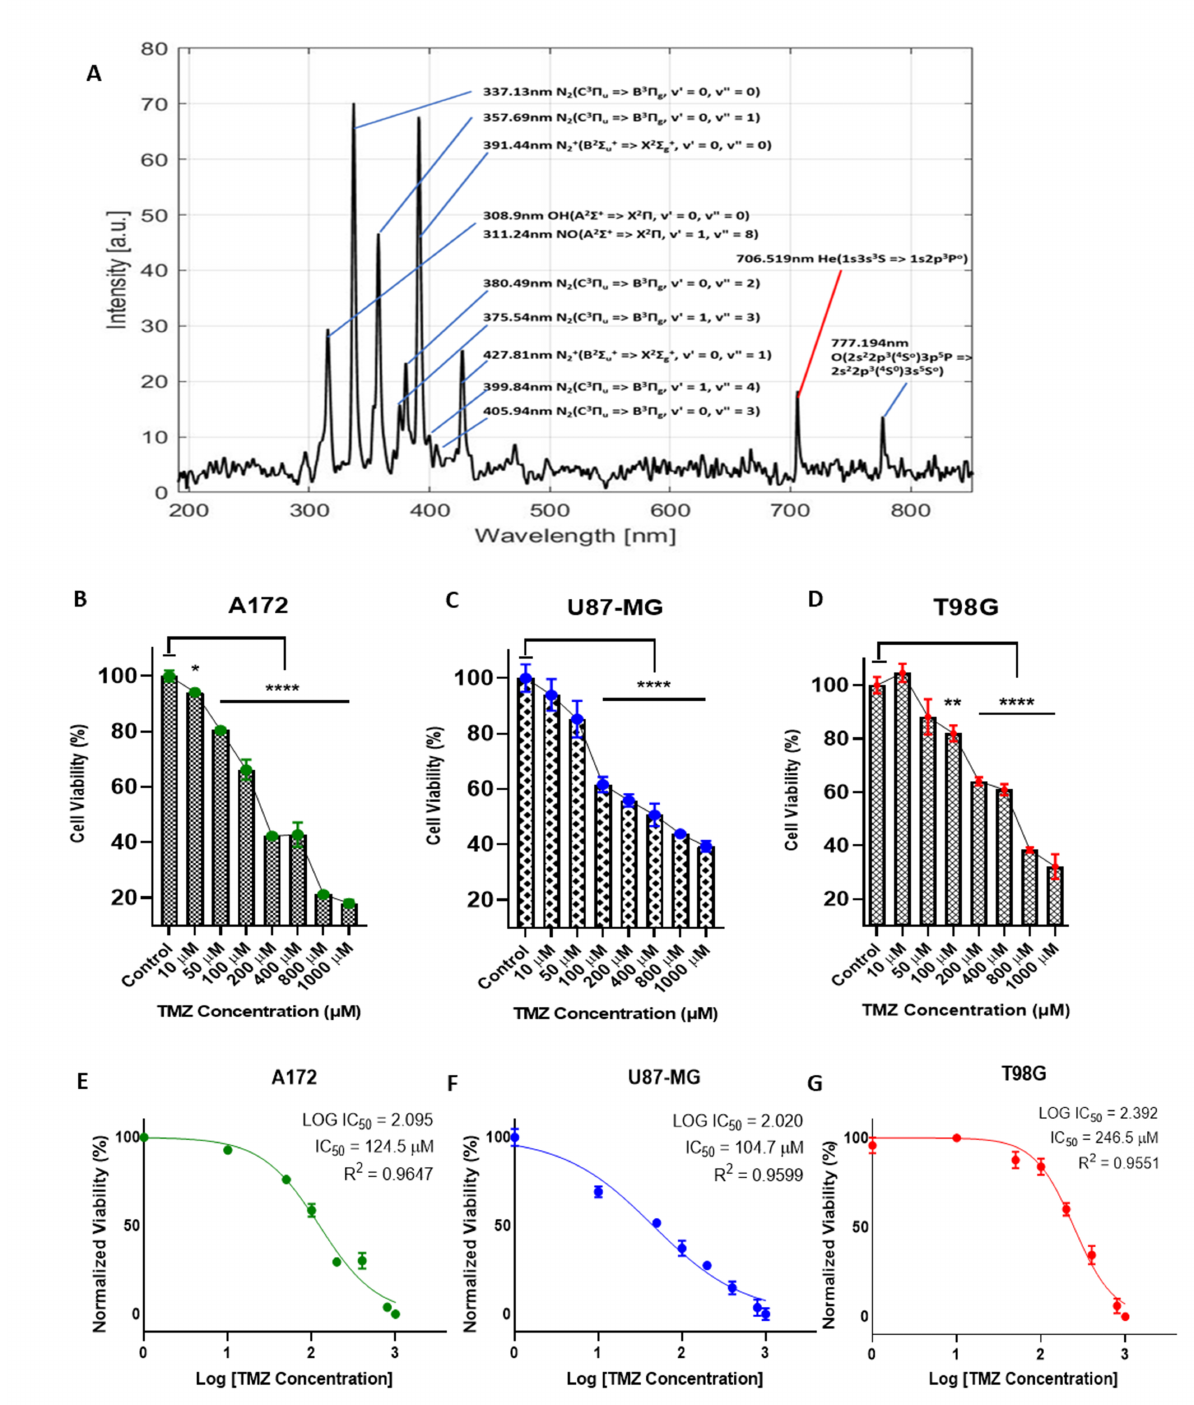
Figure 1. ( A ) Optical Emission Spectroscopy of the CAP jet using SpectraWiz ® showing most peaks of nitrogen C3 Π u => B3 Π g ranging from the spectral region of about 300–490 nm. Relative cell viability (%) for the GBM tumor cell line A172 ( B ), U87-MG ( C ), and T98G ( D ) 72 h following a single TMZ treatment. The log IC50 after 5-day TMZ treatment of A172 ( E ), U87-MG ( F ), and T98G ( G ) cell lines. Cell viability measures were collected 96 h after TMZ treatment. All data represent the mean ± SE, and all experiments were performed in quadruplets. Data were analyzed using Student’s t -test * p < 0.05; ** p < 0.01; and **** p < 0.0001, ns—not significant vs. untreated control. n =